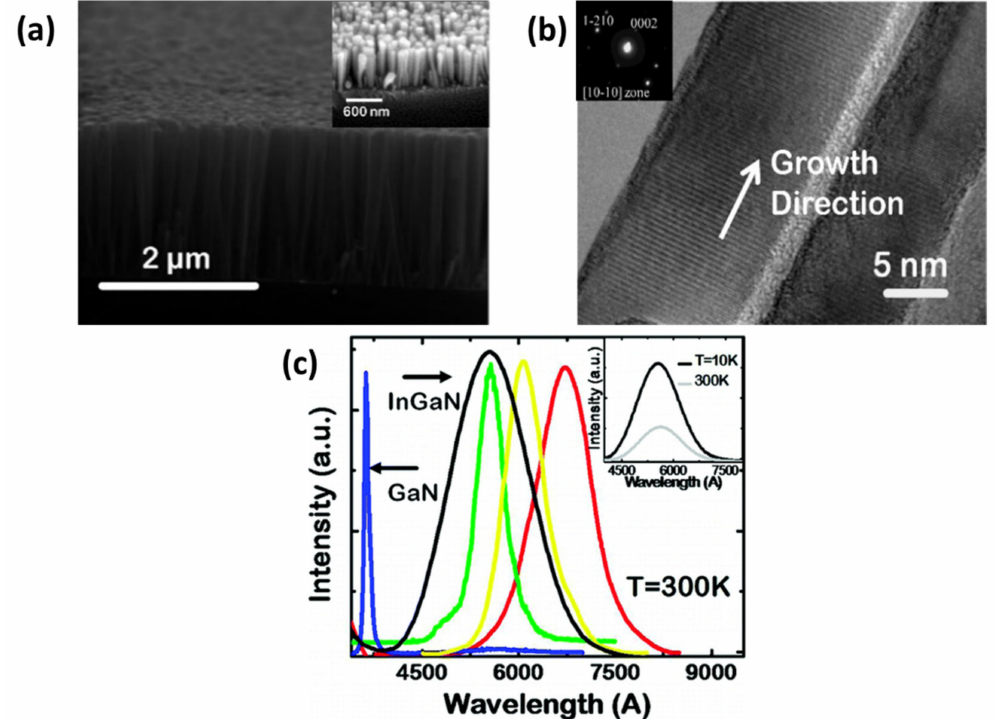
Figure 11. ( a ) Cross-sectional SEM image of InGaN nanowires grown on Si. ( b ) HRTEM image of InGaN nanowire. The inset shows the selective area diffraction pattern of the nanowire. ( c ) Room-temperature PL spectra of InGaN nanowires with different In compositions. The inset shows the 10K and RT PL of nanowires. Reproduced from [121], with permission from Copyright American Chemical Society,